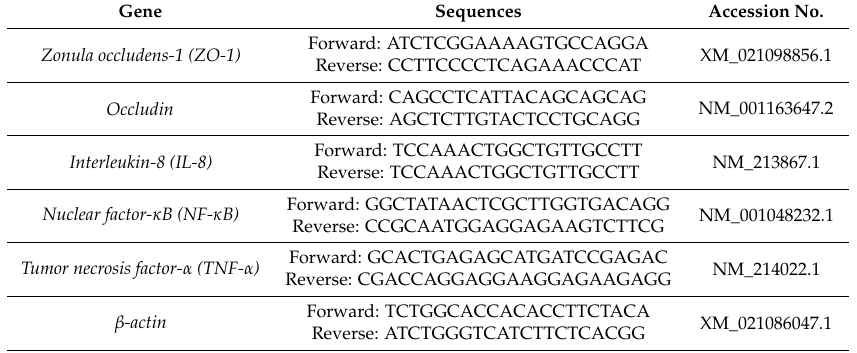
Table 6. Primers for reverse transcription quantitative real-time PCR (RT-qPCR) used in this study. Gene Sequences Accession